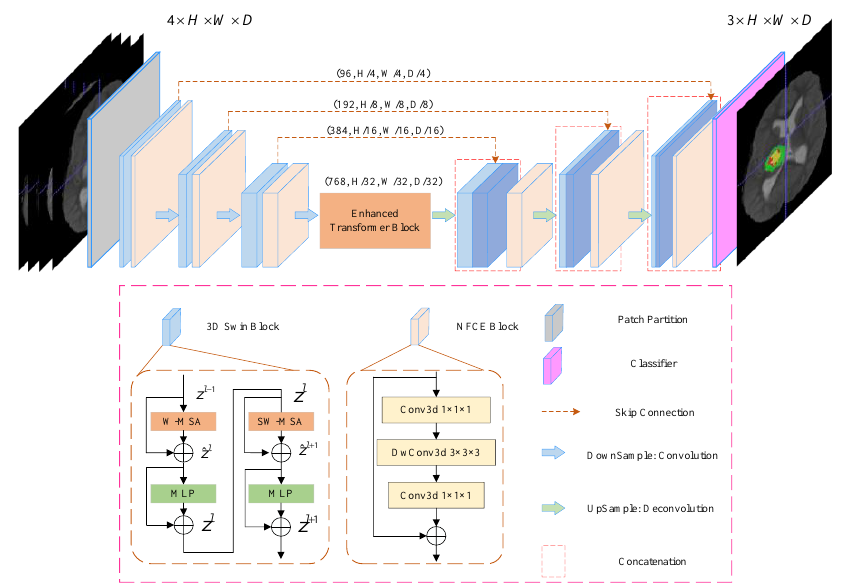
Figure 1. Overview of UNETR architecture. A 3D input volume (e.g., C = 4 channels for MRI images) is divided into a sequence of uniform non-overlapping patches and projected into an embedding space using a linear layer. The sequence is added with a position embedding and used as an input to a transformer model. The encoded representations of different layers in the transformer are extracted and merged with a decoder via skip connections to predict the final